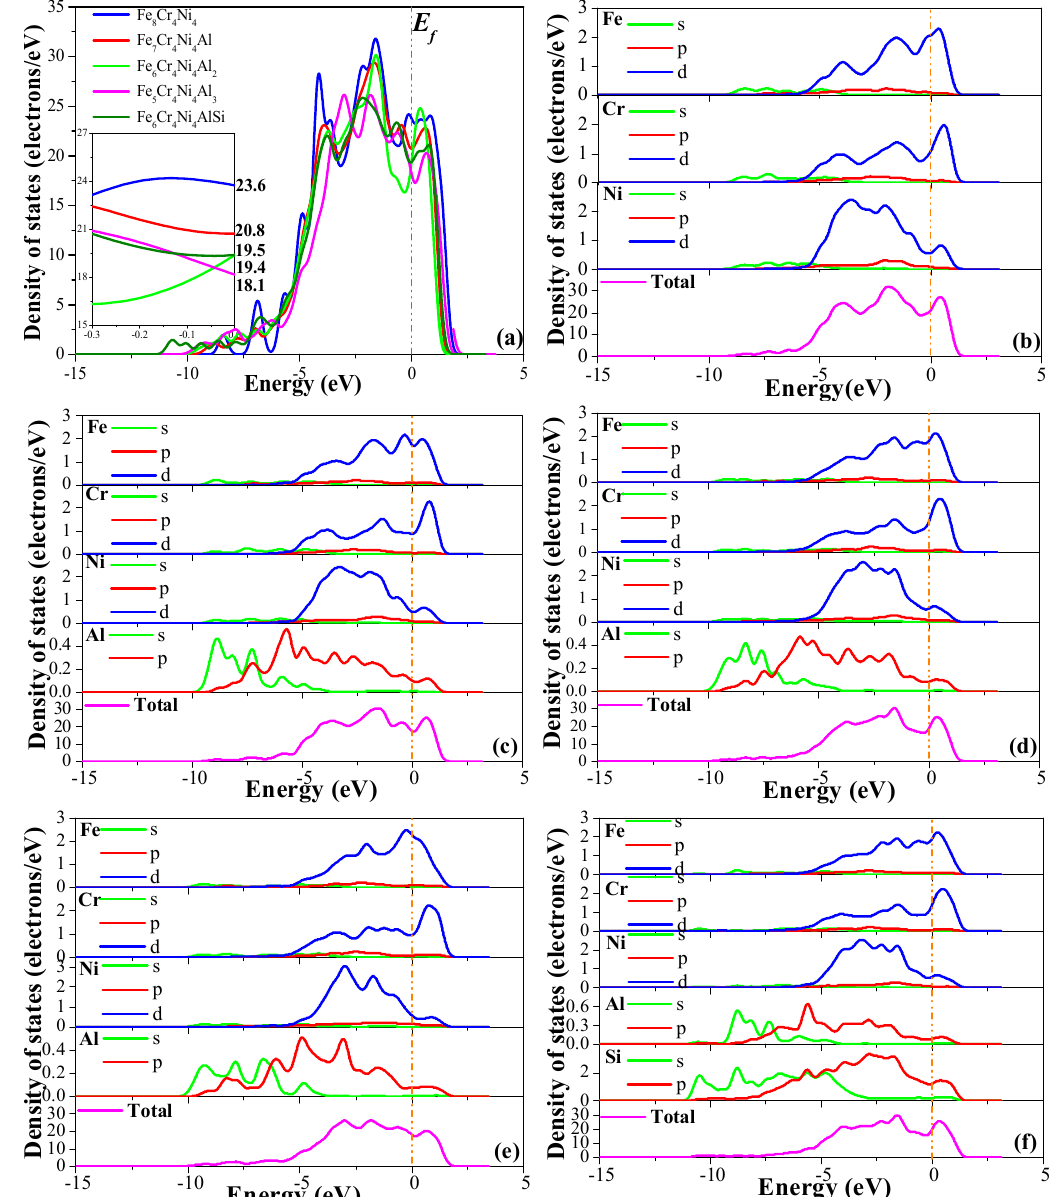
Figure 10. ( a ) Total density of states (TDOS) of different systems; partial density of states (PDOS) of different systems: ( b ) Fe 8 Cr 4 Ni 4 ; ( c ) Fe 7 Cr 4 Ni 4 Al; ( d ) Fe 6 Cr 4 Ni 4 Al 2 ; ( e ) Fe 5 Cr 4 Ni 4 Al 3 ; and ( f ) Fe 6 Cr 4 Ni 4 AlSi.